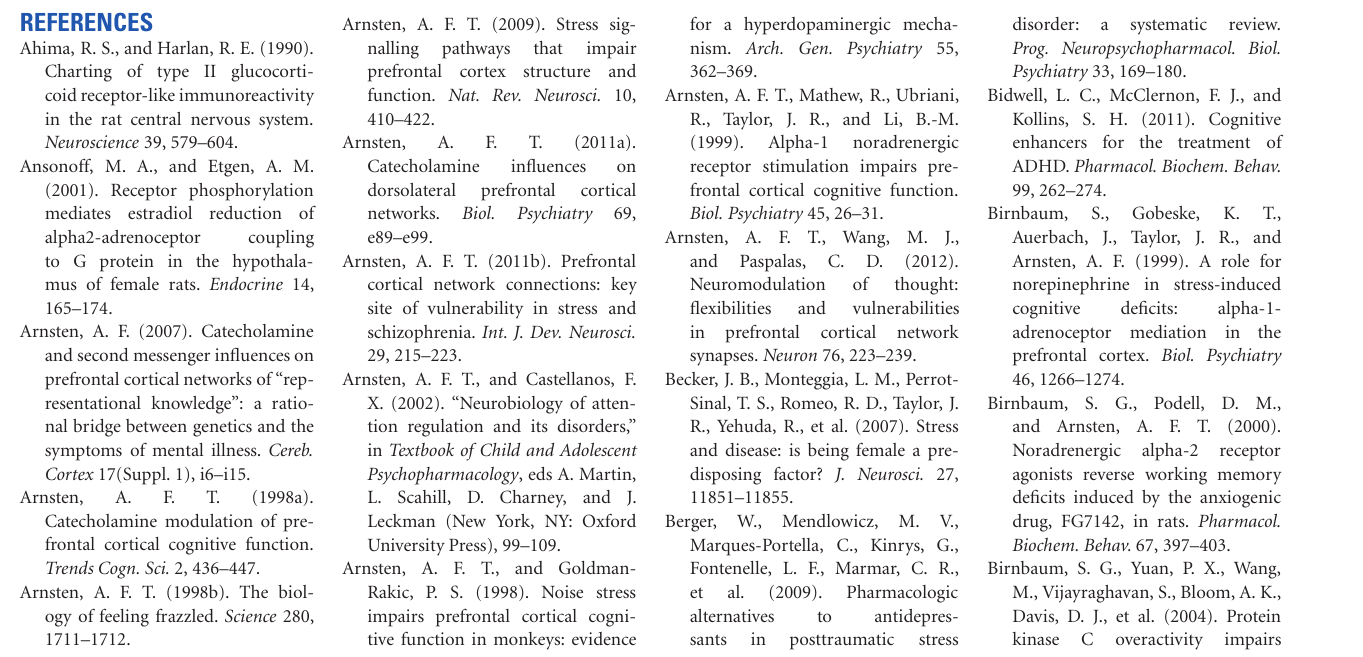
FIGURE 2 | Estrogen “ahead of the curve” hypothesis. Estrogen may amplify the stress response in females by raising baseline dopamine D1 signaling, thus making small shifts more apparent in behavioral measures. In this model, high- and low-estrogen females